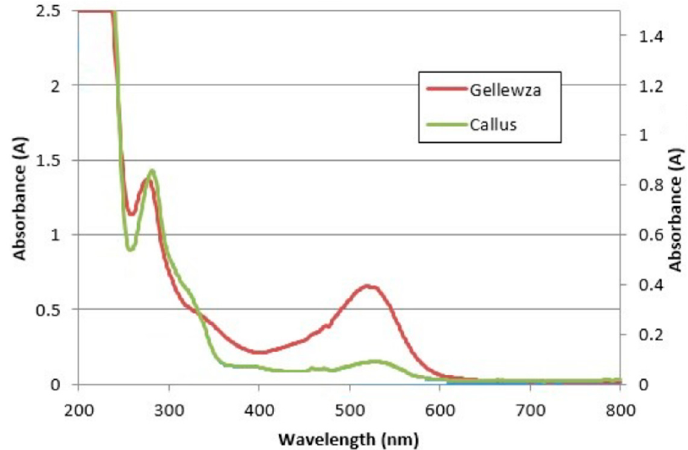
˙Gellew˙za grapes [12] and ˙Gellew˙za callus from the current Figure 1. The UV-Vis profile for Ġ ellew ż a grapes [12] and Ġ ellew ż a callus from the current study. Figure 1. The UV-Vis profile for